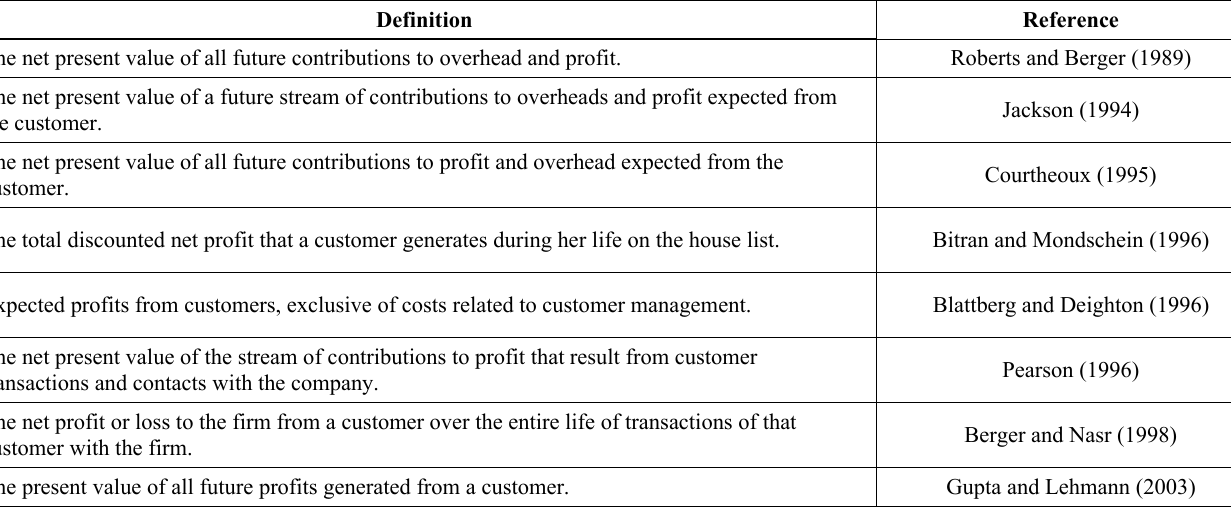
Table 3: Definitions of CLV (Hwang et al .,